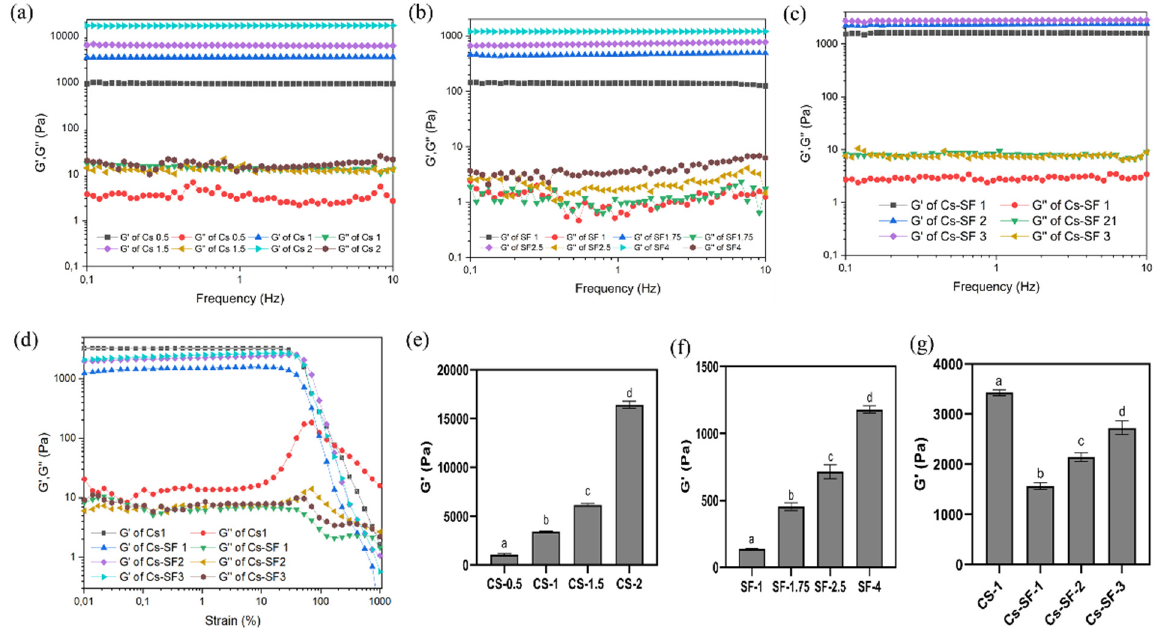
Figure 3. Rheological properties of chitosan (Cs), silk fibroin (SF), and Cs-SF hydrogels. ( a – c ) storage modulus (G’) and loss modulus (G”)—frequency dependence of Cs ( a ), SF ( b ), and Cs-SF ( c ) hydrogels at a constant strain of 1% at 37 °C; ( d ) storage modulus (G’) and loss modulus (G”)—strain dependence of Cs-1 and Cs-SF hydrogels at a constant frequency of 1 Hz at 37 °C; ( e – g ) average value of G ′ of Cs ( e ), SF ( f ), and Cs-SF ( g ) hydrogels at 1 Hz. a–d bars that do not share a letter are significantly different at p < 0.05.